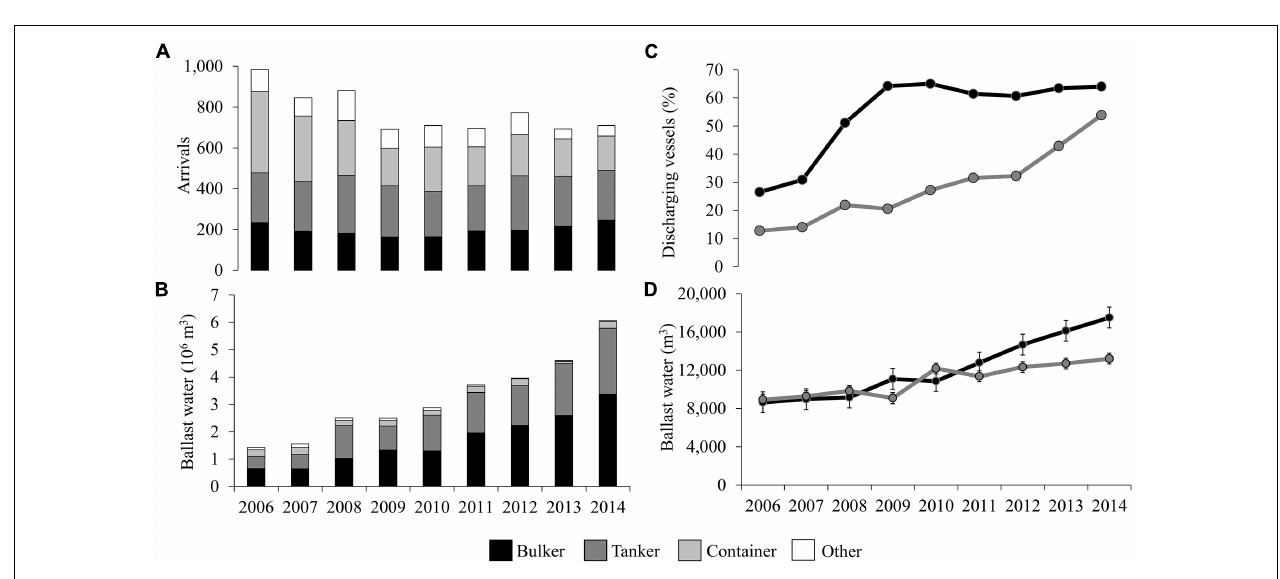
FIGURE 2 | Annual contributions of overseas and coastwise ballast water discharge (bars) and arrivals (lines) to San Francisco Bay by commercial vessels.